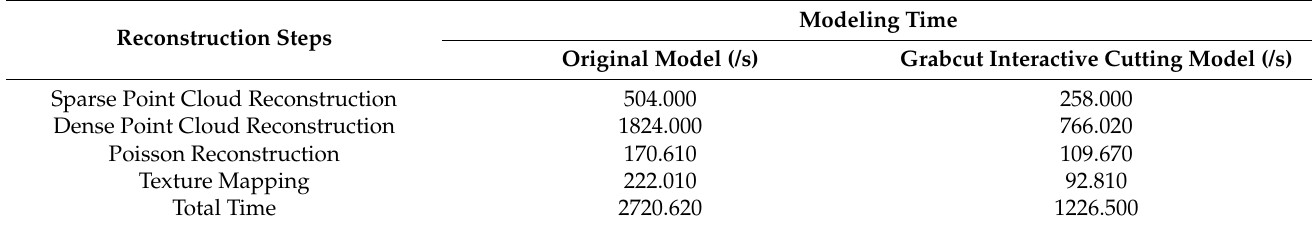
Table 1. Comparison of consumed time in 3D reconstruction.